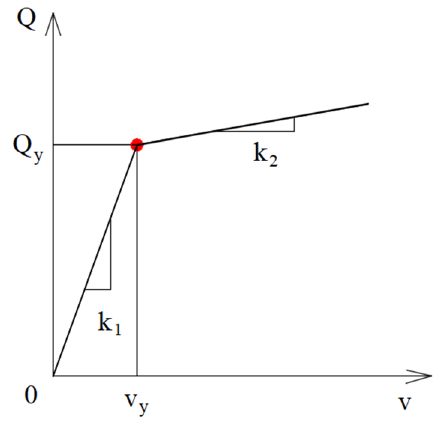
Figure 11. Shear-deformation relationship of the device.